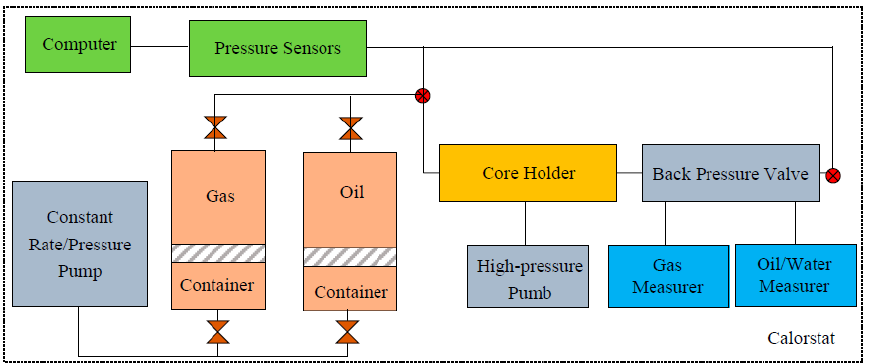
Figure 1. Experimental devices and their connection.